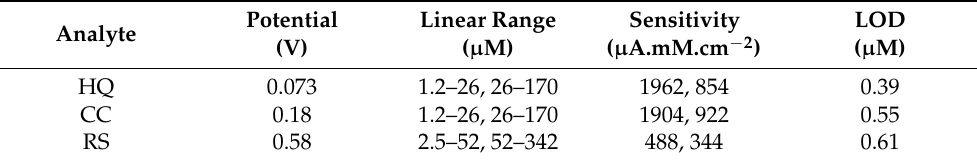
Table 1. Analytical parameters of GCE/ErGO-cMWCNT/AuNPs sensor for multianalyte detection.